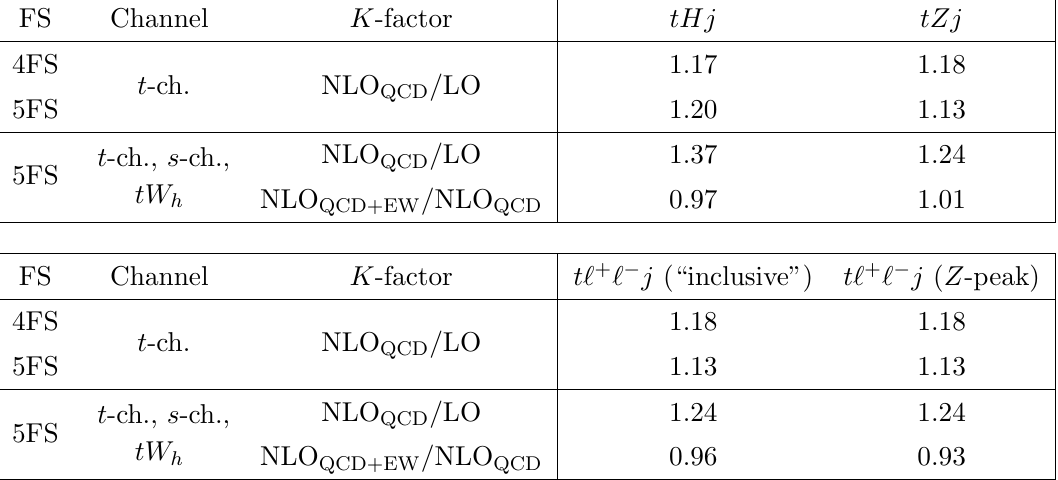
Table 2 . QCD and EW K -factors for all processes. The statistical error is beyond the digits displayed